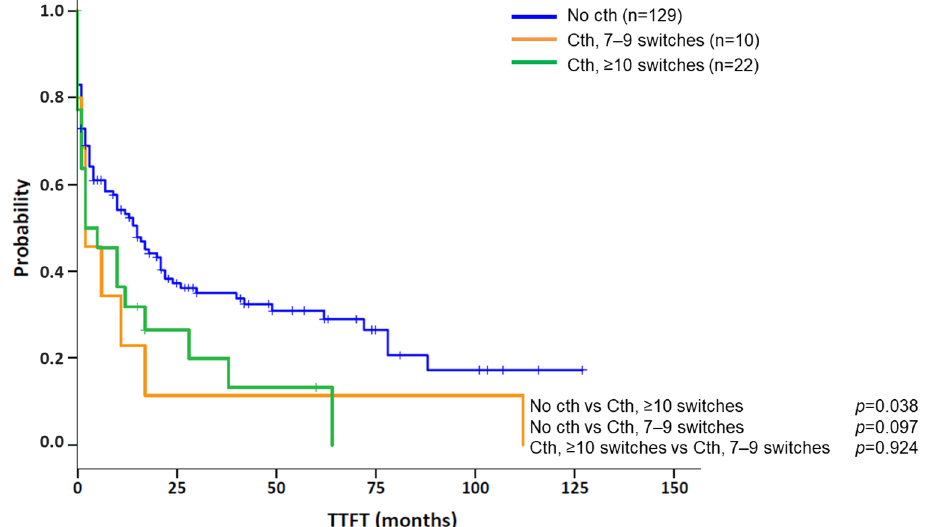
Figure 4. Kaplan–Meier plots for time to first treatment (TTFT) based on the presence of chromothripsis and the number of oscillating switches found in chromothripsis patterns. Kaplan–Meier estimation for TTFT in patients with 7–9 switches between 2–3 copy number states and ≥ 10 switches between 2–3 copy number states compared to a cohort of CLL cases carrying a complex karyotype (CK) without chromothripsis (cth). Of note, patients were classified into the “Cth ≥ 10 switches” group if they showed at least one chromothripsis event with these characteristics.